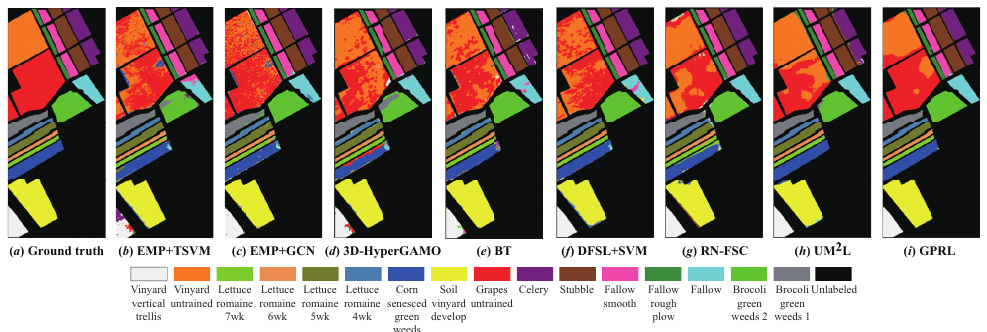
Figure 8. The classification maps of different methods on the SA data